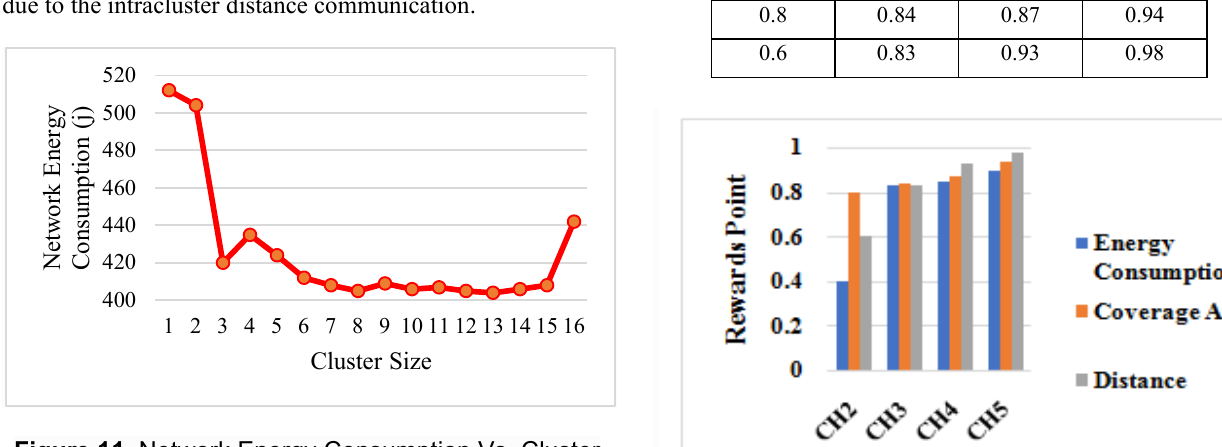
Figure 11. Network Energy Consumption Vs. Cluster Size Figure 12. Reward point for Energy Consumption, Coverage Area, and Distance